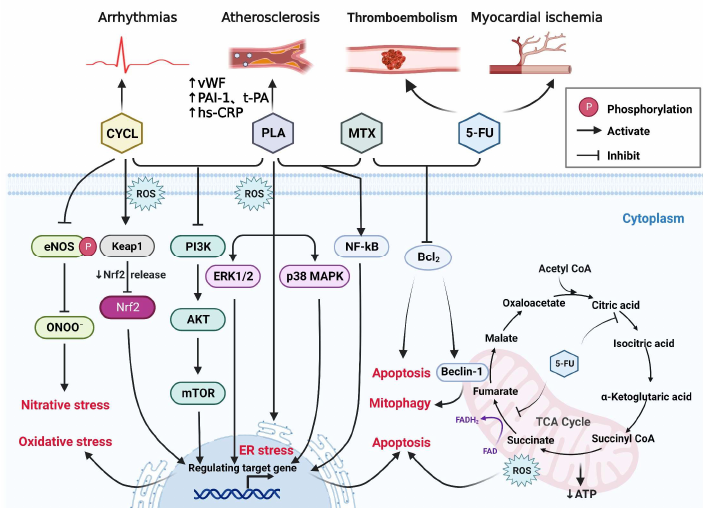
Figure 2. Mechanisms of non-anthracycline-based chemotherapeutic cardiotoxicity. The mechanisms of cisplatin toxicity to the heart include oxidative stress, inflammation, endoplasmic reticulum stress, and activation of ERK1/2 and p38 MAPK pathways. Cyclophosphamide causes myocardial injury mainly by inducing oxidative stress, nitrative stress, and inhibiting the PI3K/AKT/mTOR pathway. MTX activates proinflammatory pathways, inhibits Bcl2 expression, and induces cardiomyocyte apoptosis. 5-FU activates mitophagy and blocks the TCA cycle, thereby causing mitochondrial dysfunction. CYCL, cyclophosphamide; PLA, platinum; vWF, von Willebrand factor; t-PA, tissue plasminogen activator; hs-CRP, high-sensitivity C-reactive protein, PAI-1, plasminogen activator inhibitor; NF-κB, nuclear factor kappa B; eNOS, endothelial nitric oxide synthase; Keap1, Kelch-like ECH-associated protein 1; Nrf2, nuclear factor erythroid 2-related factor 2. Created with BioRender.com.